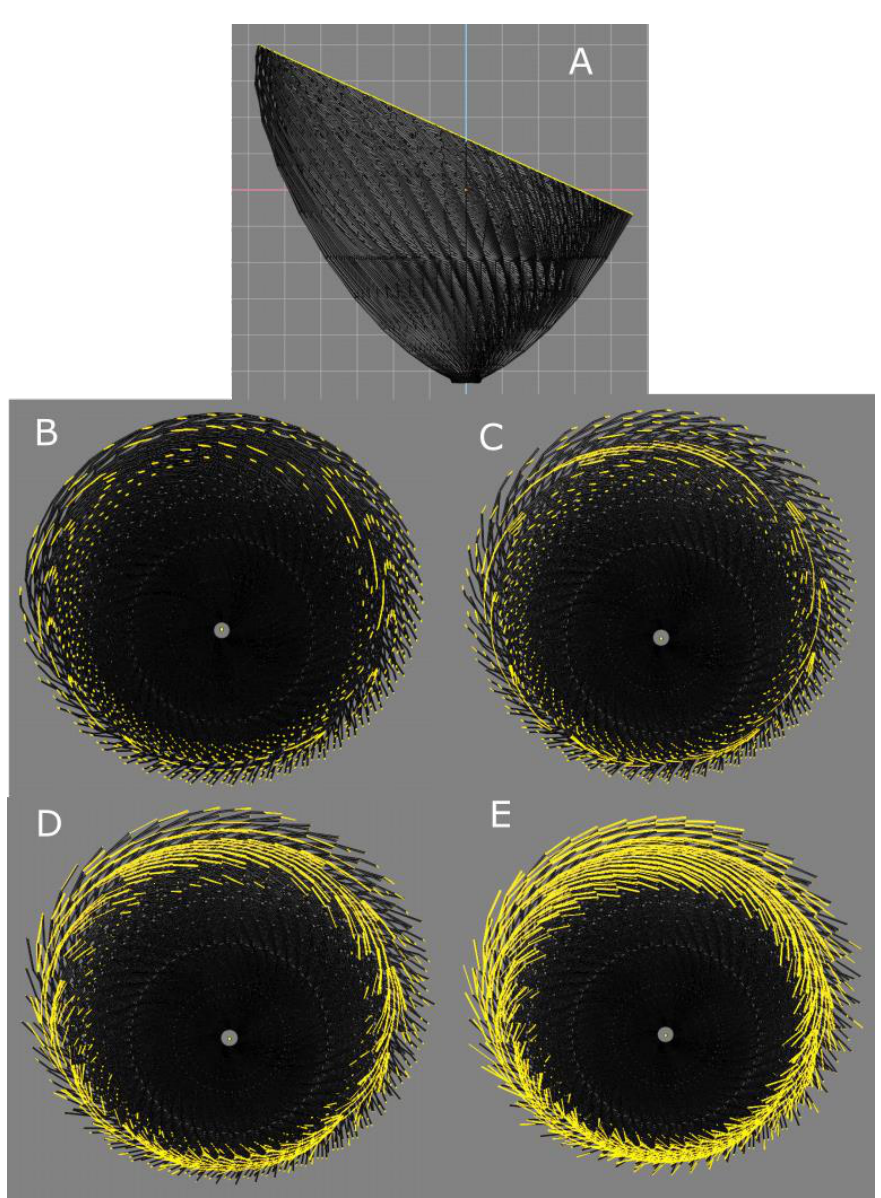
Figure 8. Examples of paralines and emergence of ortholines. 3D model — ten nested tori, each covered by one hundred geodesics. Theoretically, a geodesic is a curve and has no thickness, but, for the sake of representation, we gave it an arbitrary thickness or diameter as if it were spaghetti. ( A ) Side view of an oblique section of a set of ten nested tori, each covered by one hundred geodesics (object size 100 mm). ( B – E ) Slices with different thicknesses. The views are perpendicular to the section plane in A. ( B ) Minimal thickness slice: ortholines are resulting from the alignment of a few distinct geodesic segments. They made the measurement of an intrusion angle with the epicardial tangent plane possible. ( C ) Slice with same thickness as the diameter of the geodesic. This extends the length of in-plane geodesics, but the pattern becomes messy. ( D ) Slice with a thickness equivalent to three geodesic diameters. Emergence of paralines, i.e., the end-to-end juxtaposition of geodesic fragments running on different tori. ( E ) Slice thickness of five geodesic